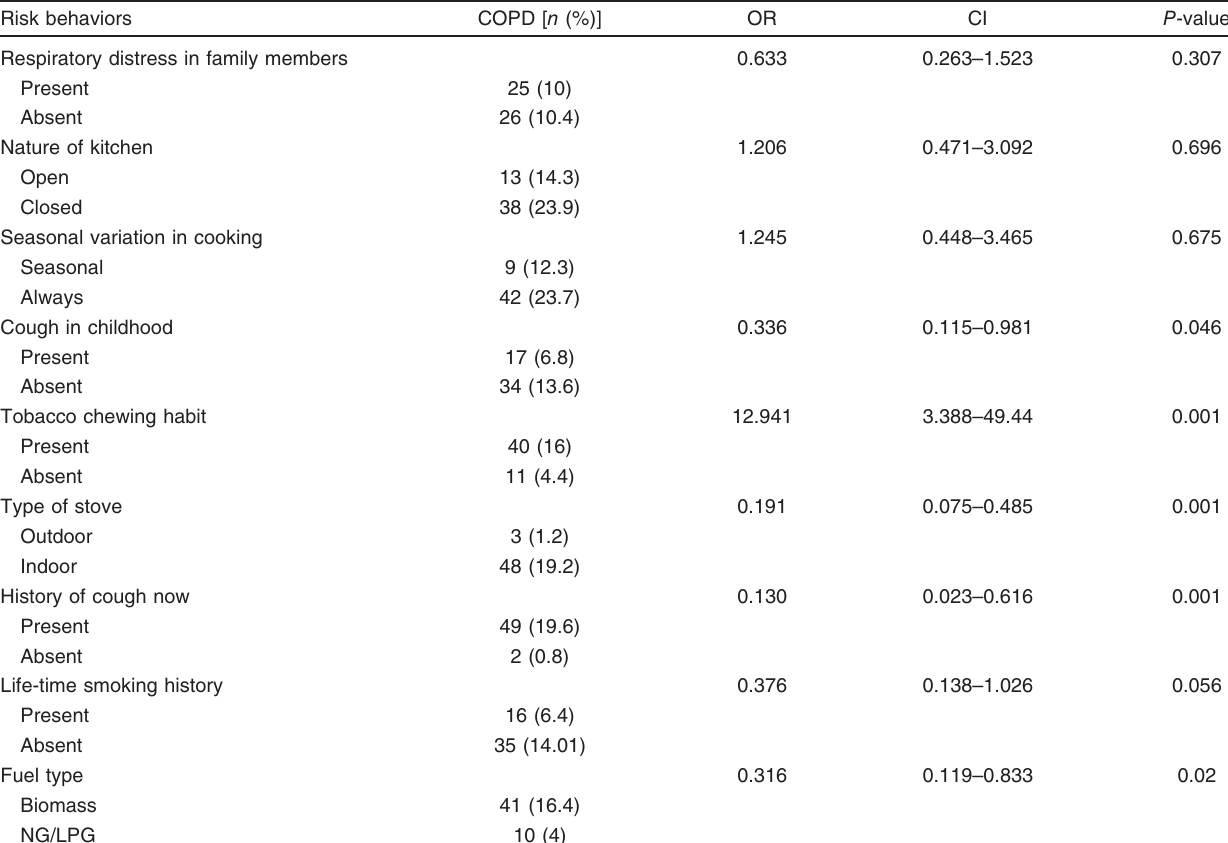
Table 3 Association or risk factors with chronic obstructive pulmonary disease Risk behaviors